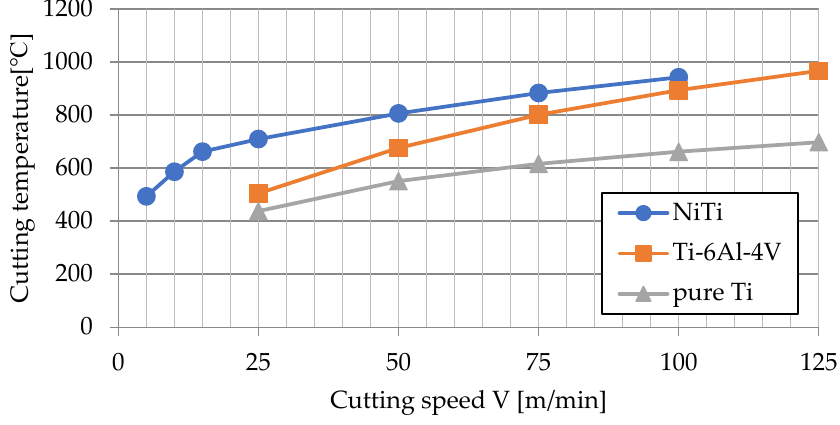
Figure 3. Cutting temperature at different cutting speeds for various materials.